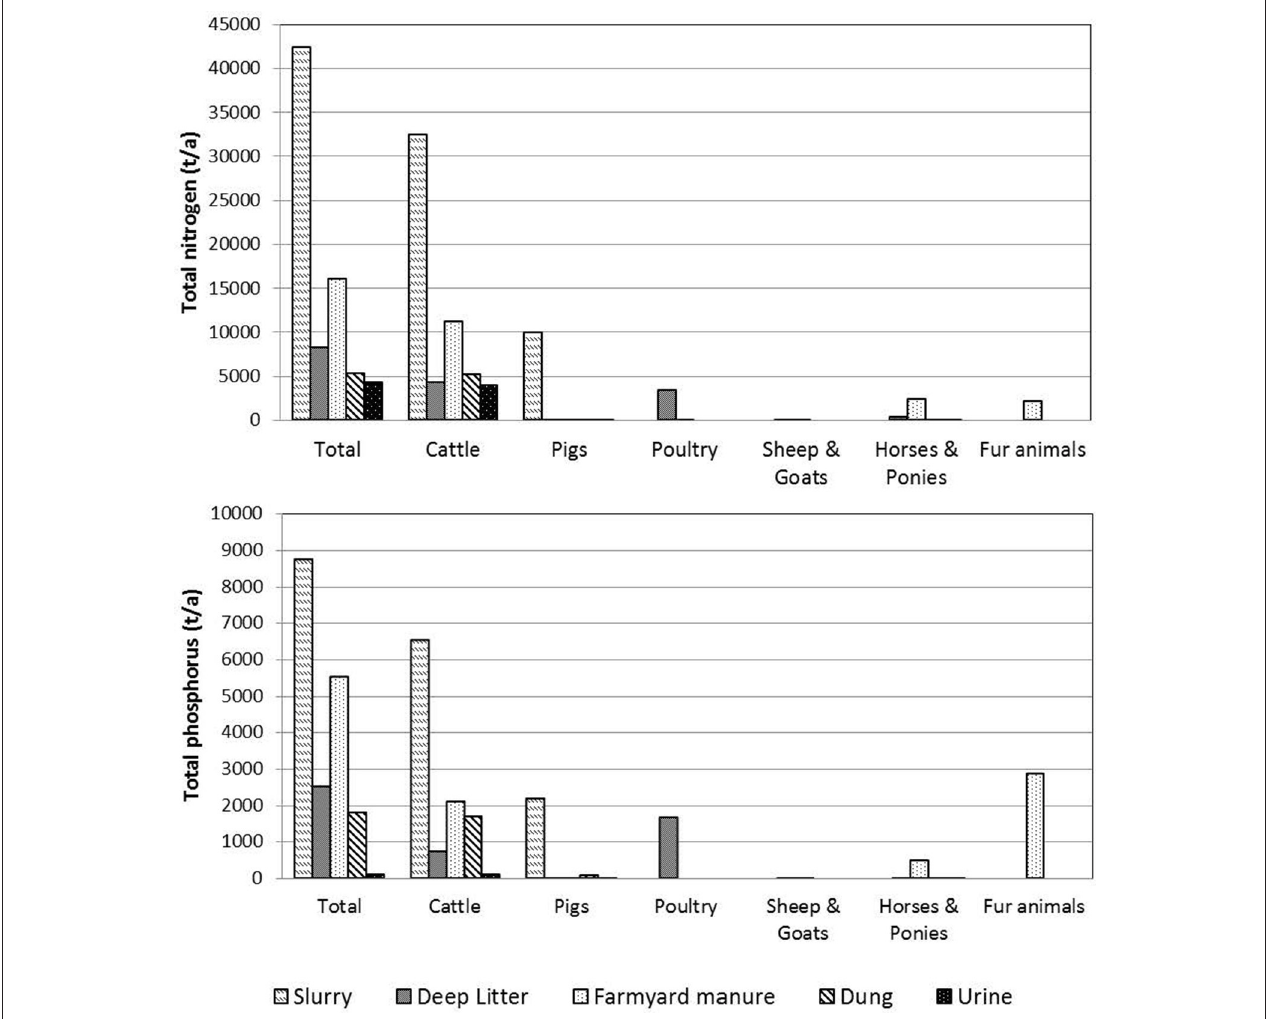
FIGURE 3 | Total nitrogen (above) and phosphorus (below) in all manures ex storage in Finland as calculated with the Normative Manure System and animal statistics of 2016. Manure excreted on pasture is